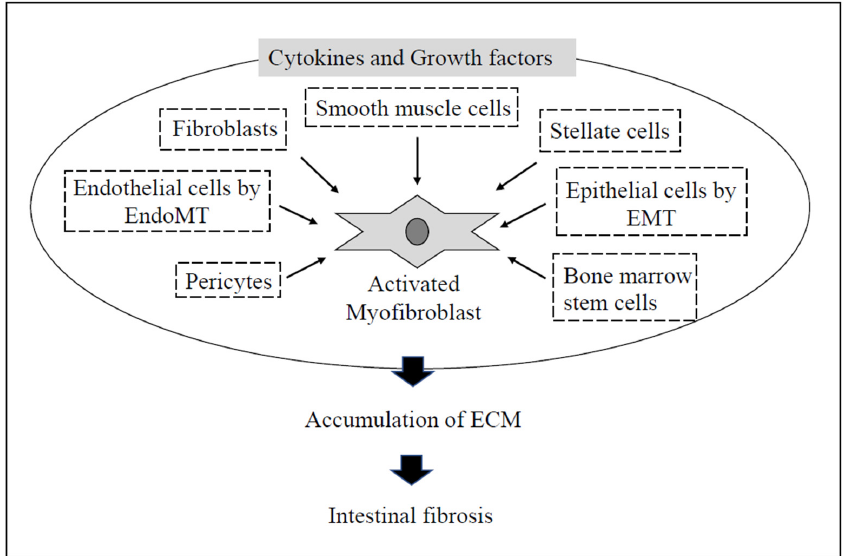
Figure 1. Differentiation into activated myofibroblasts in the intestine. Activated myofibroblasts are the center of fibrosis. Activated myofibroblasts differentiate from various cells such as epithelial